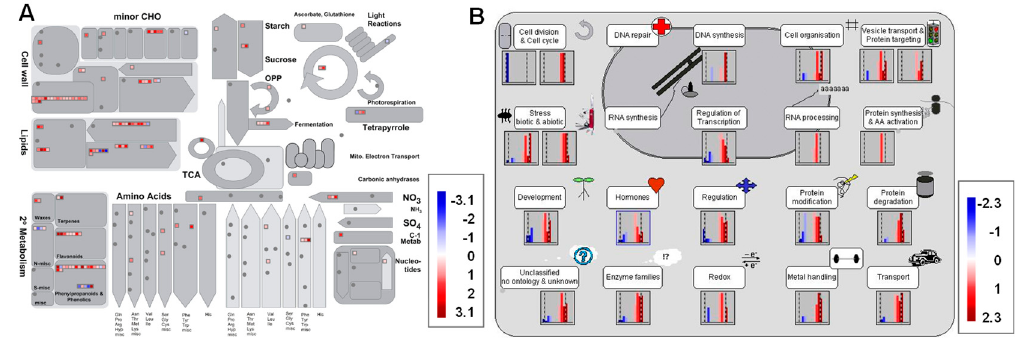
Figure 4. The Kyoto Encyclopedia of Genes and Genomes (KEGG) pathway enrichment scatter plot of DEGs. ( A ) KEGG pathway enrichment analysis for up-regulated genes. ( B ) KEGG pathway enrichment analysis for down-regulated genes. The x -axis indicates the rich factor, and the degree of KEGG pathway enrichment. The y -axis indicates the name of the KEGG pathway. The dot size means the gene number. The dot color indicates the q -value. The top 20 KEGG pathways are shown.